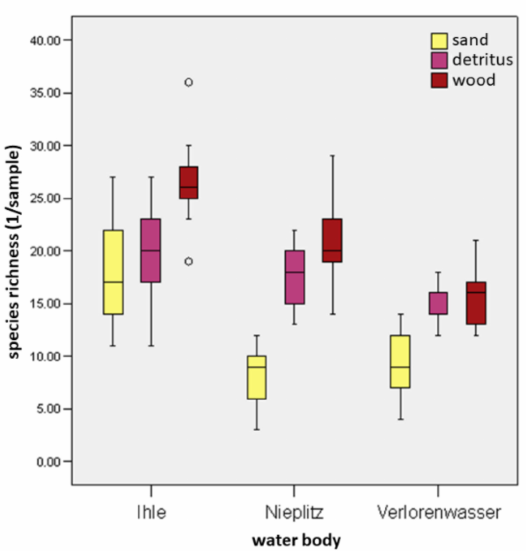
Figure 7. Species richness of the macroinvertebrates per sample for the substrates sand, detritus and wood of the WS, related to the streams Ihle (except gravel), Nieplitz, and Verlorenwasser. The box plots show the minimum (lower antenna), the two quartiles, the median, and the maximum (upper antenna) of the distributions. The circles marks are suspected to be